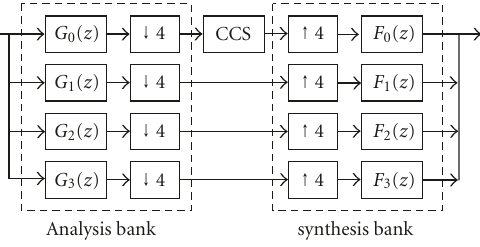
Figure 5: The block diagram of the bandlimited CCS.